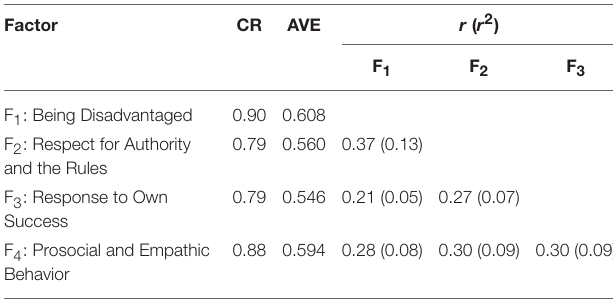
TABLE 6 | Composite reliability indices, extracted variance indices, and correlations between the factors of average students. Factor